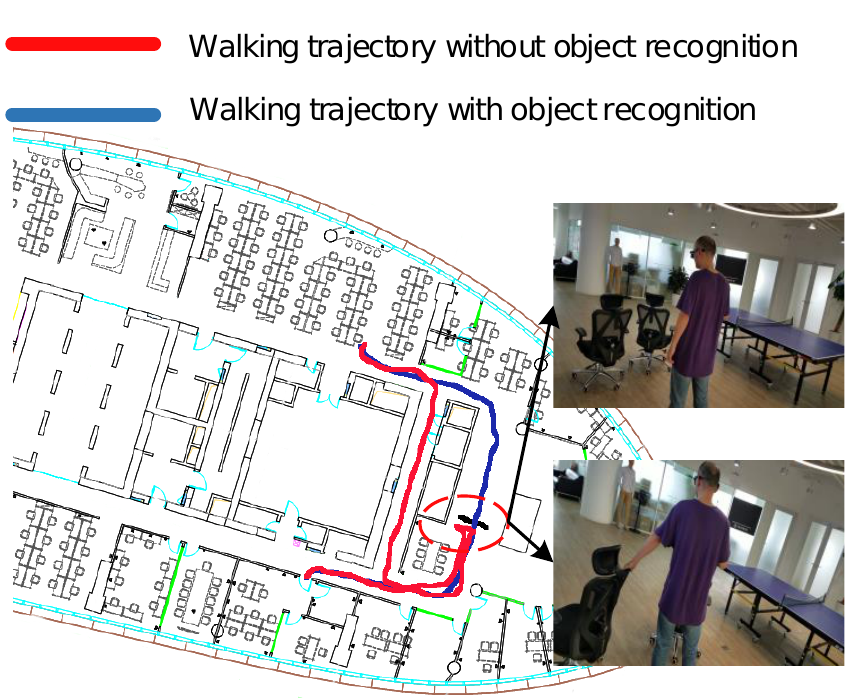
Figure 16. Test scenario of object recognition to improve the navigation.